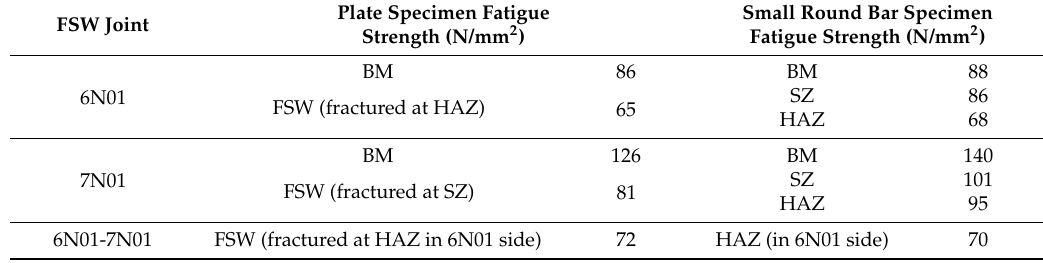
Table 3. Fatigue strength σ w at 10 7 cycles under R = 0.1 of the FSW joints.